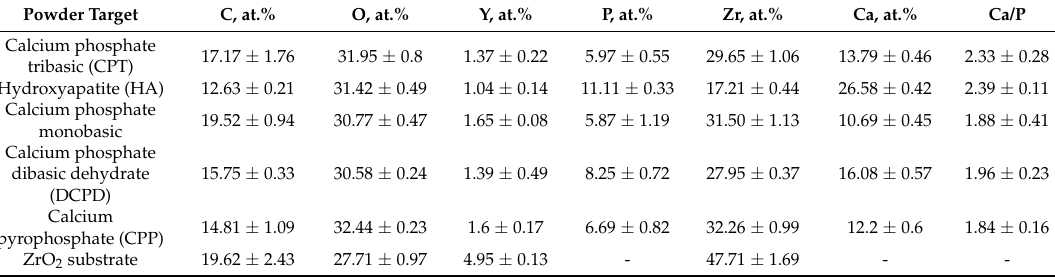
Table 3. Elemental compositions of the Ca-P coatings (means ± standard